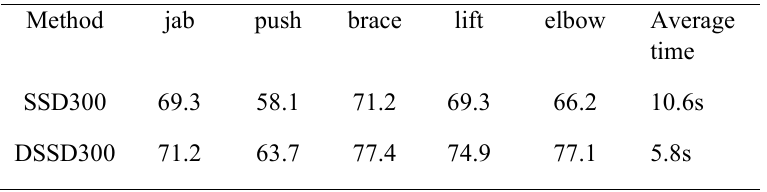
Table 6. AP results of CKP-DC and other methods on Wushu